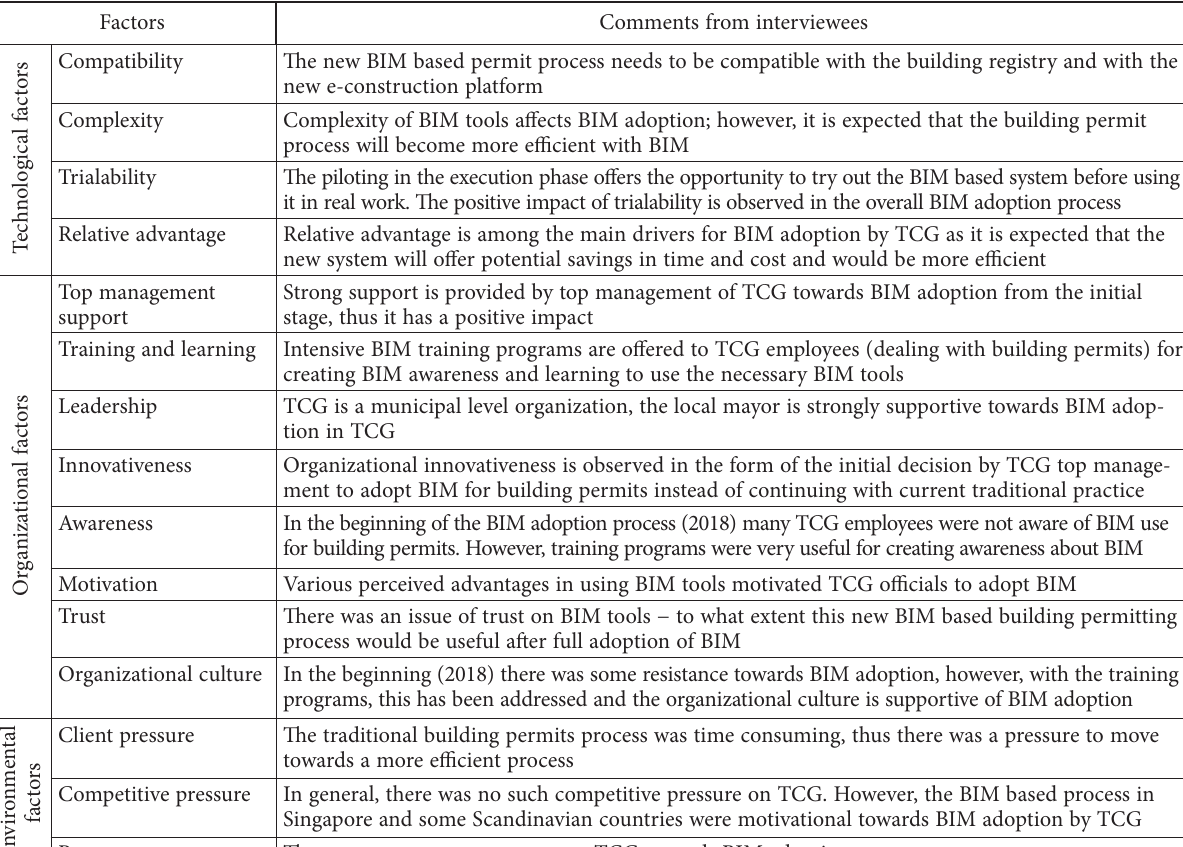
Table 5. Factors affecting BIM adoption in